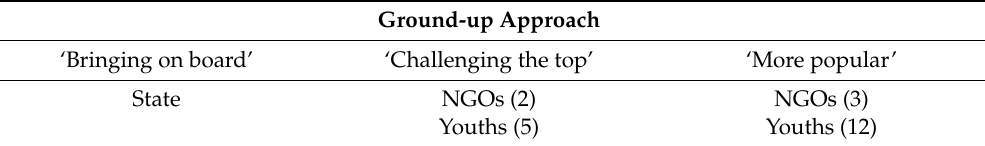
Table 2. Different discourses for Ground-up approach.